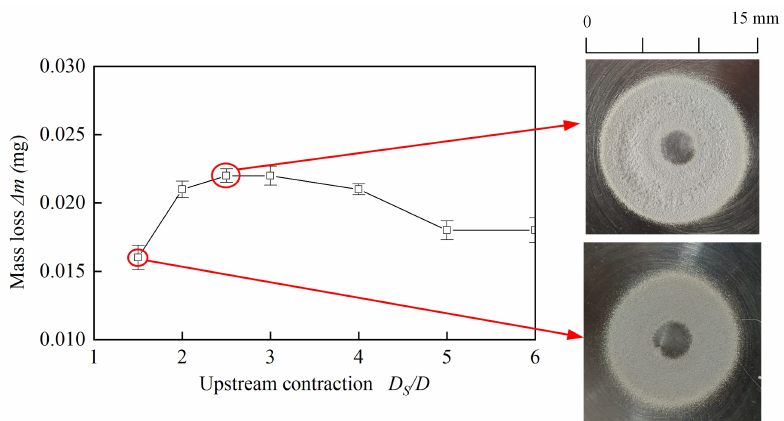
Figure 6. Mass loss and macroscopic appearance as a function of upstream contraction ratio D s / D